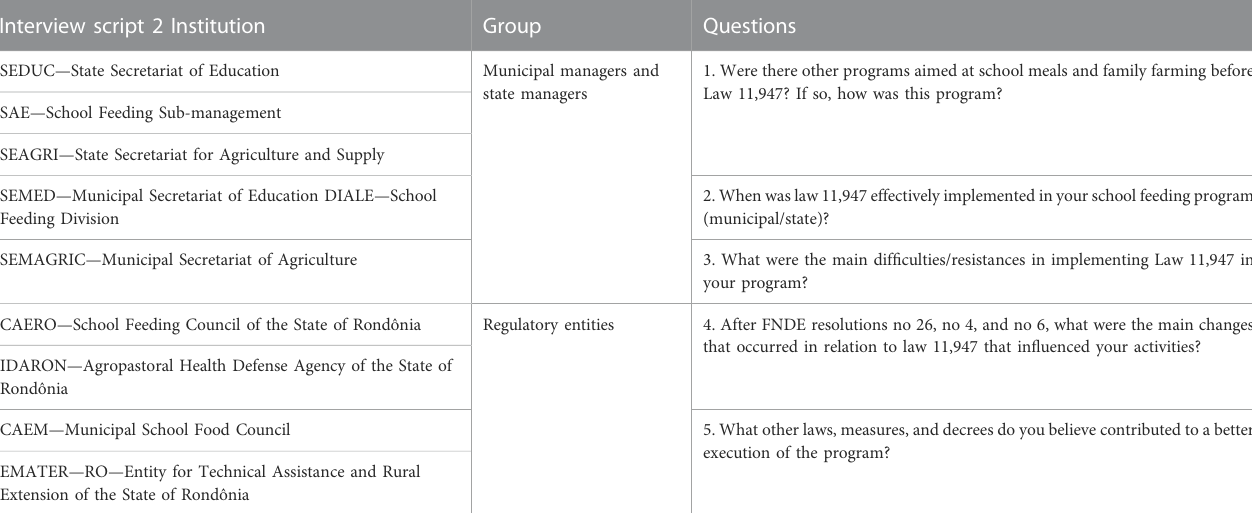
TABLE 3 Interview script 2 for municipal managers and state managers and regulatory entities groups of the PNAE (National School Feeding Program) in the municipality of Porto Velho, State of Rondônia (Brazil), aiming to characterize the activity system generated by Law No.